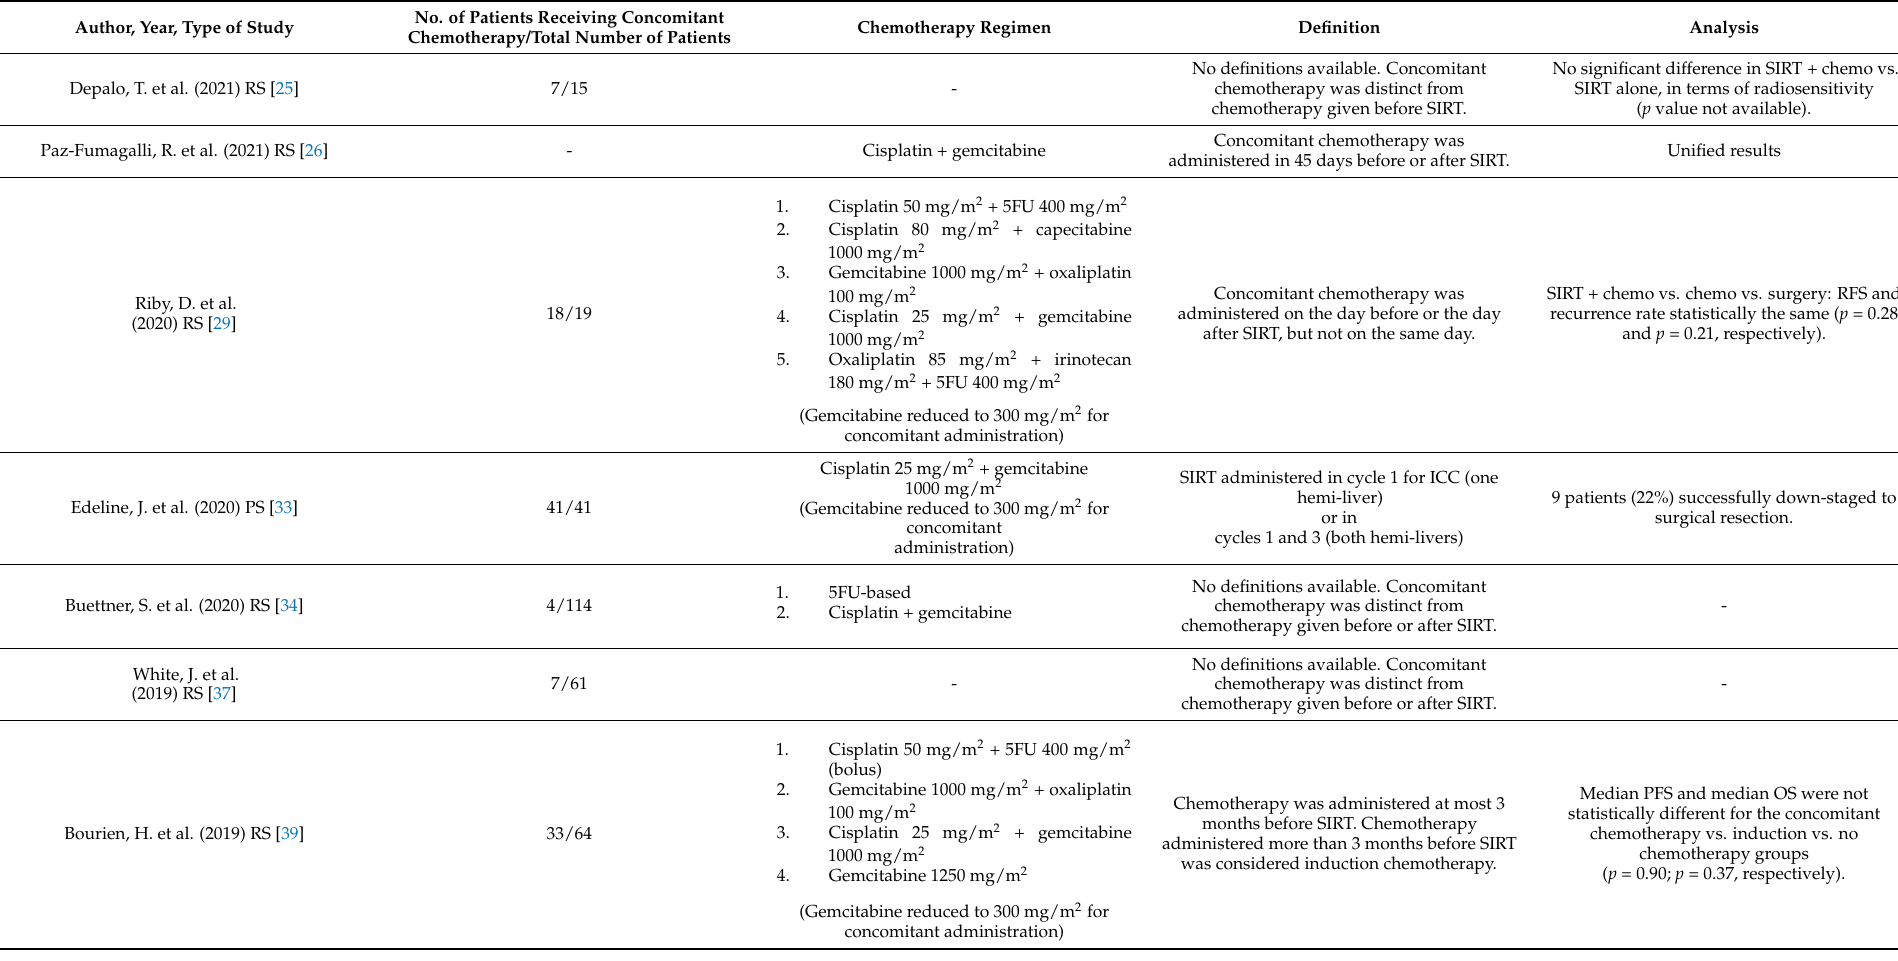
Table 3. Studies in which SIRT and chemotherapy were given concomitantly to at least 1